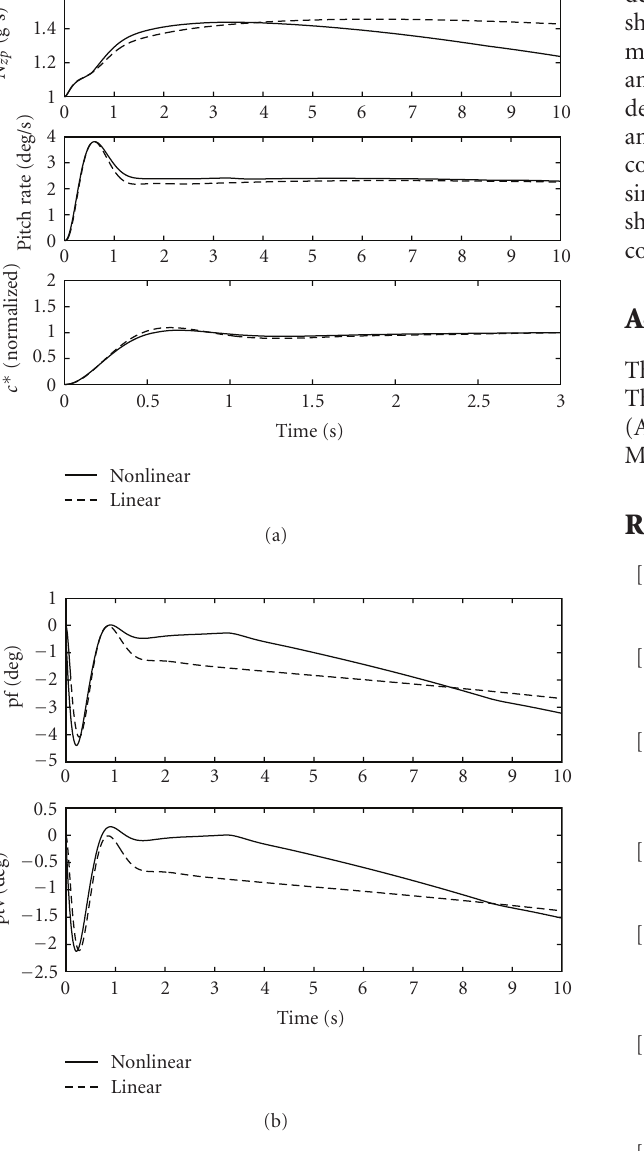
Figure 10: Nonlinear time responses to a 1 g cstar step. within the category I flight envelope of [11] and (2) the linear and nonlinear responses are similar until approximately 5 seconds when the nonlinear normal acceleration tends to its one g equilibrium value. The maximum pitch flap and pitch thrust vector deflections are 4.5 deg and 2.2 deg, respectively, for a maximum of 1.4 g normal